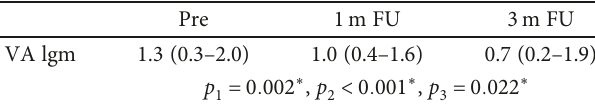
Table 3: LogMar visual acuity change.